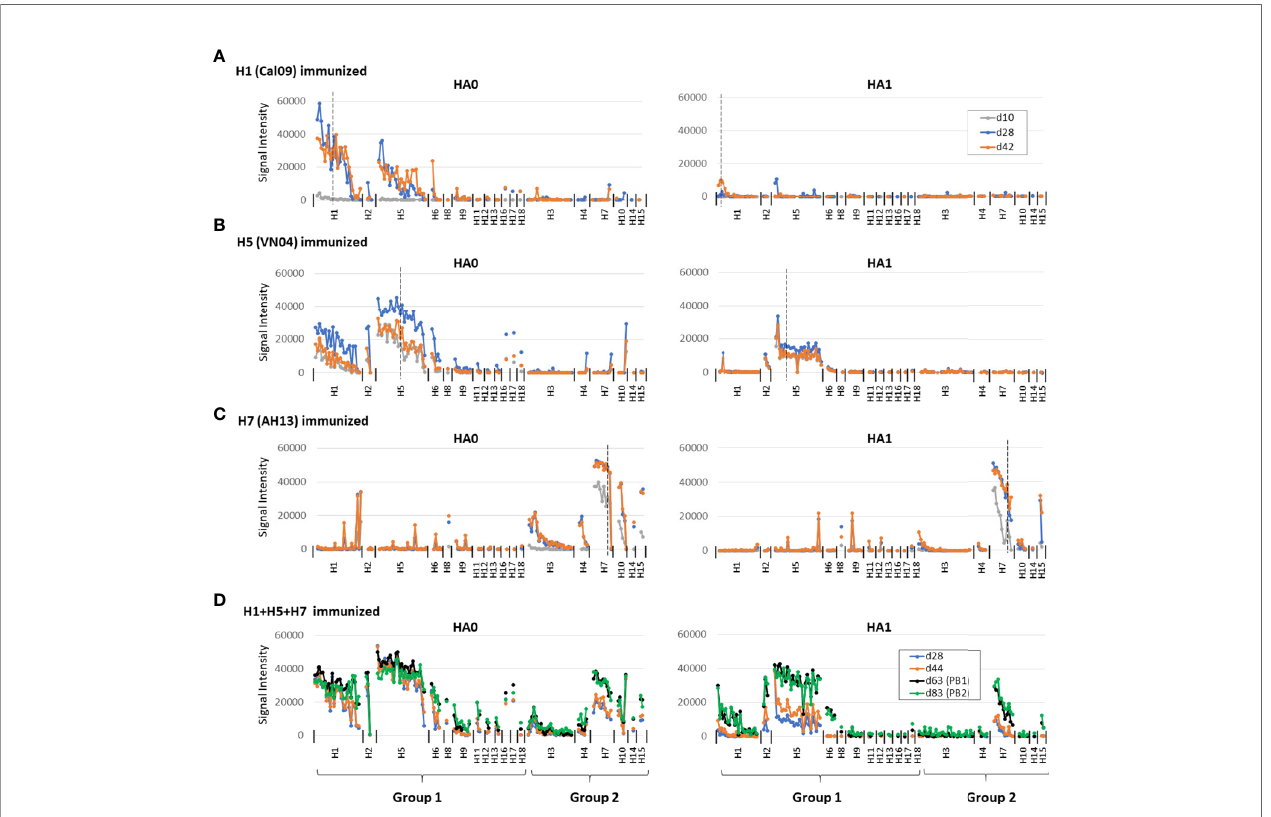
FIGURE 2 | Administration of adjuvanted individual recombinant HAs induces homosubtypic and heterosubtypic cross-reactivity. (A – C) IgG pro fi les of C57Bl/6 mice at three time points (days 10, 28 and 42) after a single-dose s.c. administration of recombinant Cal09 H1, VN04 H5 or H13 H7 trimers, respectively, (2.5 m g/mouse) in IVAX-1 adjuvant (comprising CpG, MPLA and squalene-in-water emulsion, AddaVax ™ ; N=5 mice per group; (D) IgG pro fi les for C57Bl/6 mice (N=6) at four time points after administration of trivalent cocktail (2.5 m g each) of Cal09 H1 + VN04 H5 + AH13 H7 in IVAX-1 adjuvant on d0, d50 and d72; plasma samples were collected on d28, d44, d63 (post-boost 1, PB1) and d83 (PB2). Pro fi les were determined using HA protein microarrays comprising 125 full length HA monomers (HA0, left side panels) and 131 HA1 regions (right side panels), spanning 18 different HA subtypes. Points are means of signal intensities for each vaccine group for each arrayed antigen. The ranking of antigens from left to right is the same in each panel: group 1 proteins are ranked by descending mean of H1+H5 immunized groups, while group 2 proteins are ranked by descending mean of H7 immunized mice. Vertical dashed line shows position of immunizing HA (or closest homolog). Animals that received antigen without adjuvant did not produce detectable IgG (data not shown). Data are representative of two independent experiments. See Table 1 for numbers of seropositive